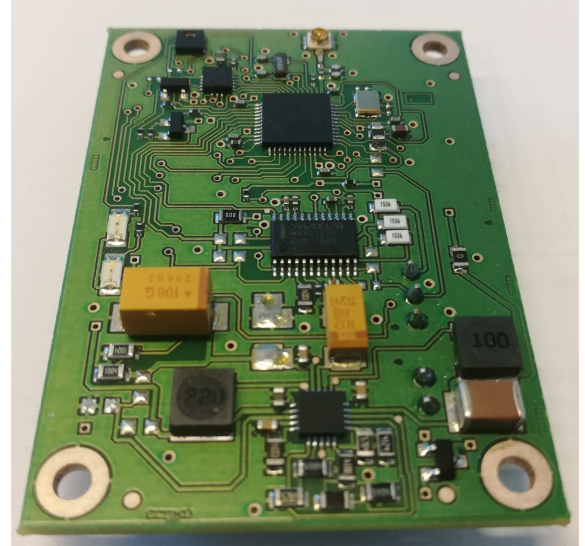
Figure 3. An integrated sensor node by Solmu